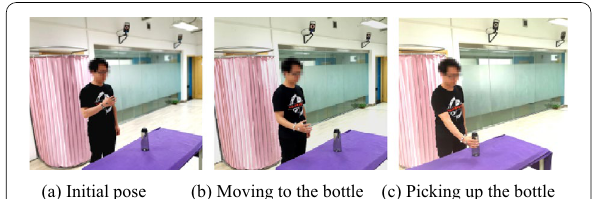
Figure 2 Human demonstrations for the pick-up